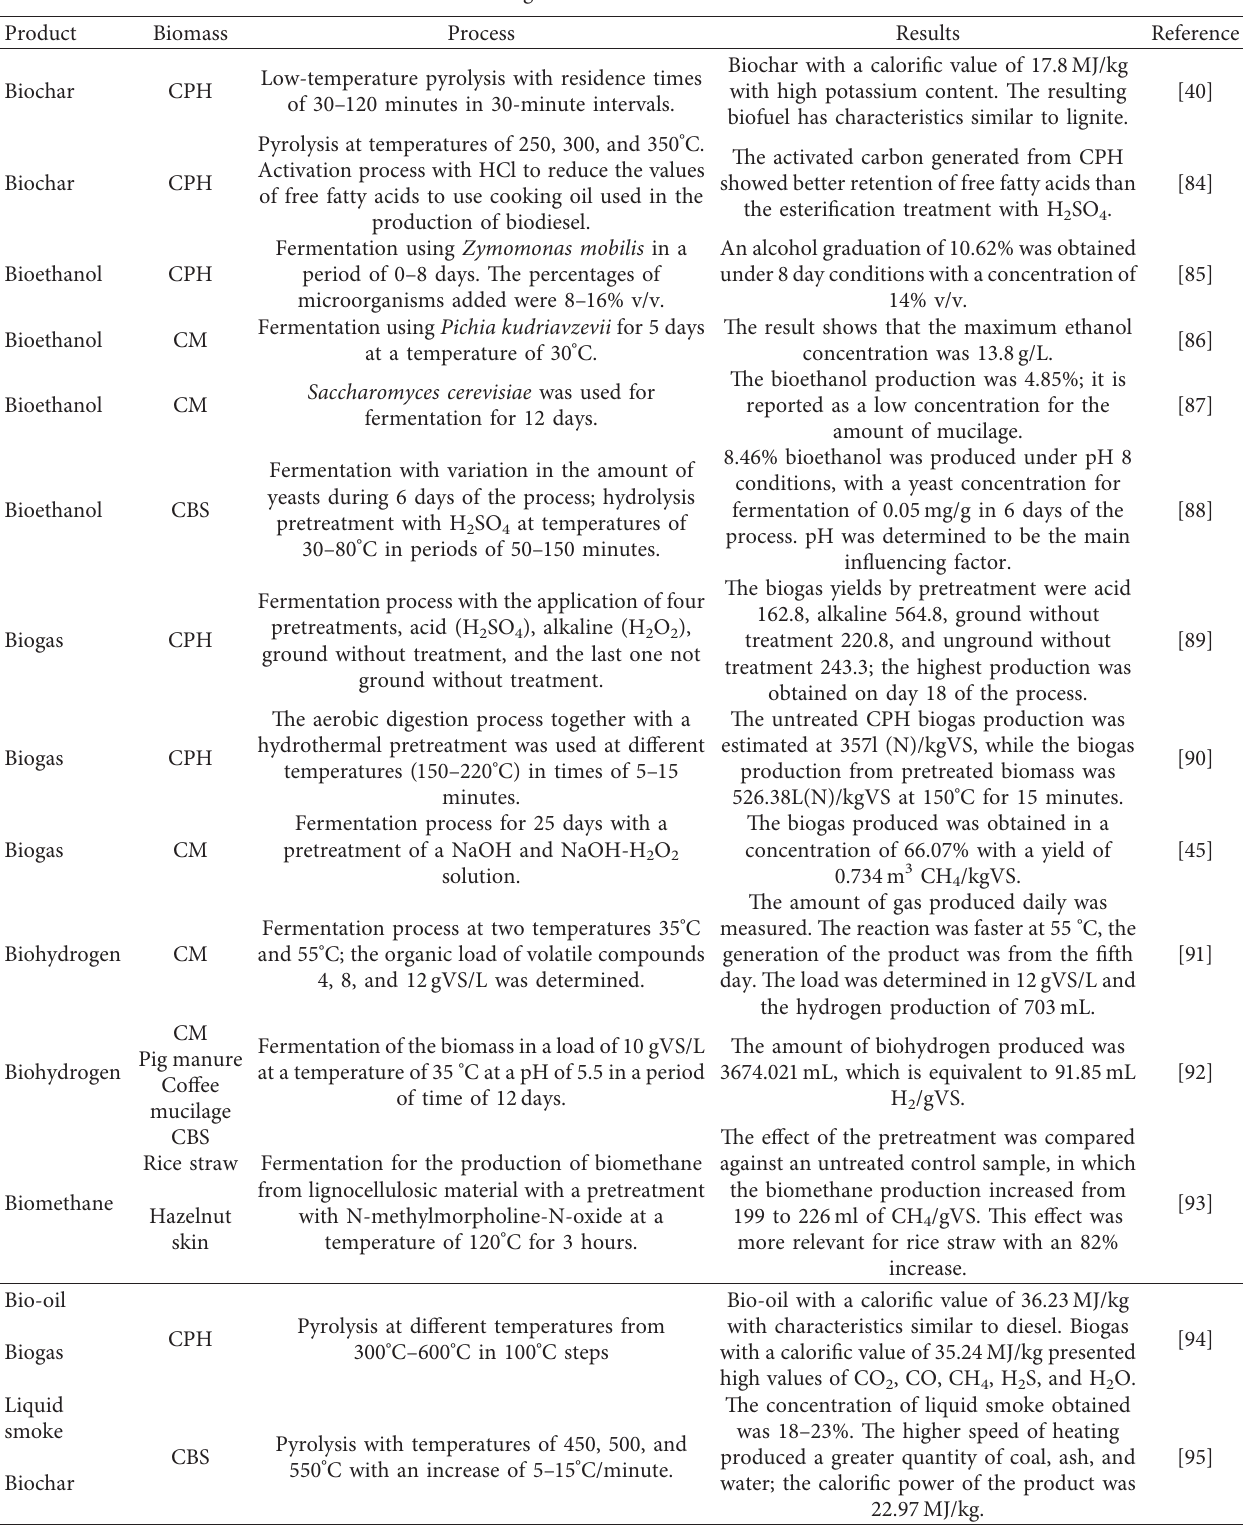
Table 3: Biofuels generated from cocoa industrial